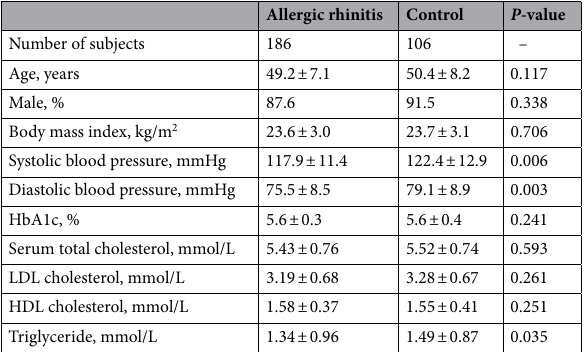
Table 1. Characteristics of study participants. Values are shown as mean ± standard deviation or frequency. P -values were calculated using the Wilcoxon rank sum test for continuous variables or Fisher’s exact test for discrete variables. No adjustments were made for statistical tests shown in this table. HDL indicates high- density lipoprotein; LDL, low-density